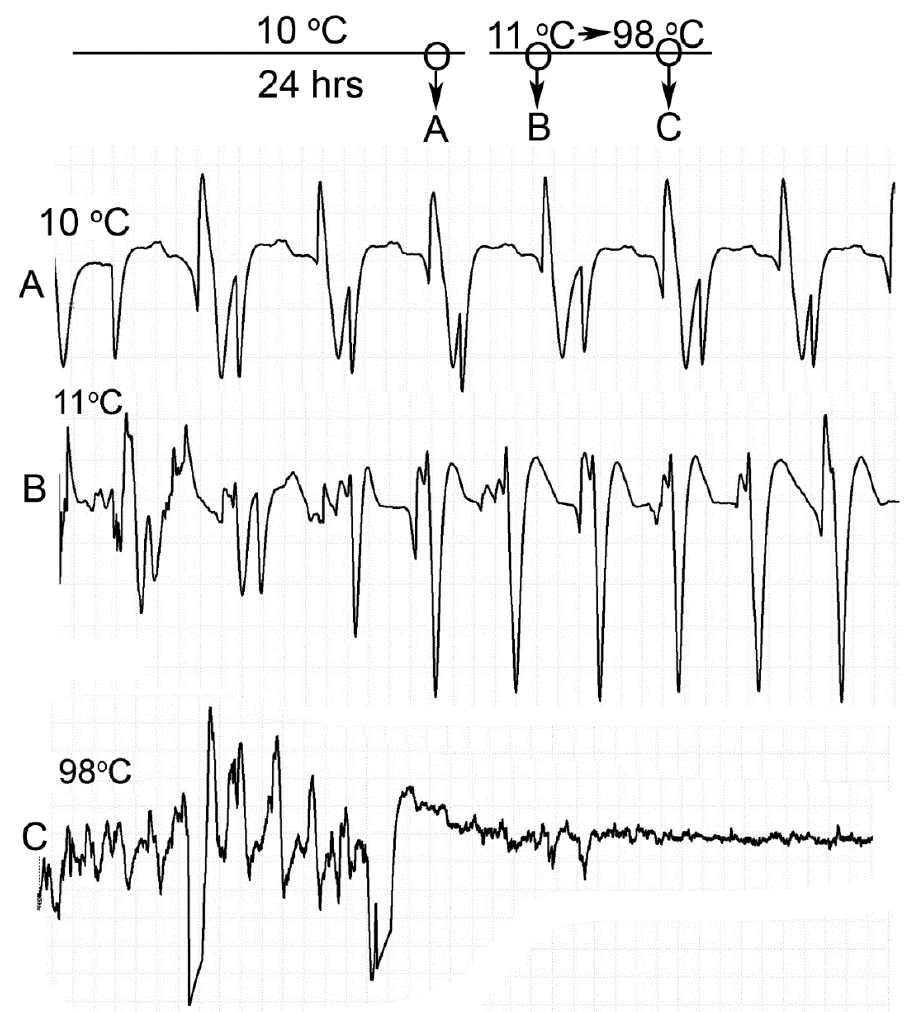
Figure 8. Heart rate measures at 11 ◦ C and boiling water at 98 ◦ C. The crayfish was conditioned to 10 ◦ C for 24 h. ( A ) A representative ECG trace of a crayfish placed in a container at 10 ◦ C after 24 h. ( B ) The crayfish was moved from one container to another with water at 11 ◦ C to determine if the ECG trace was maintained with movement. ( C ) The impedance began recording immediately when placing the crayfish into the boiling water. Each trace is 20 s in